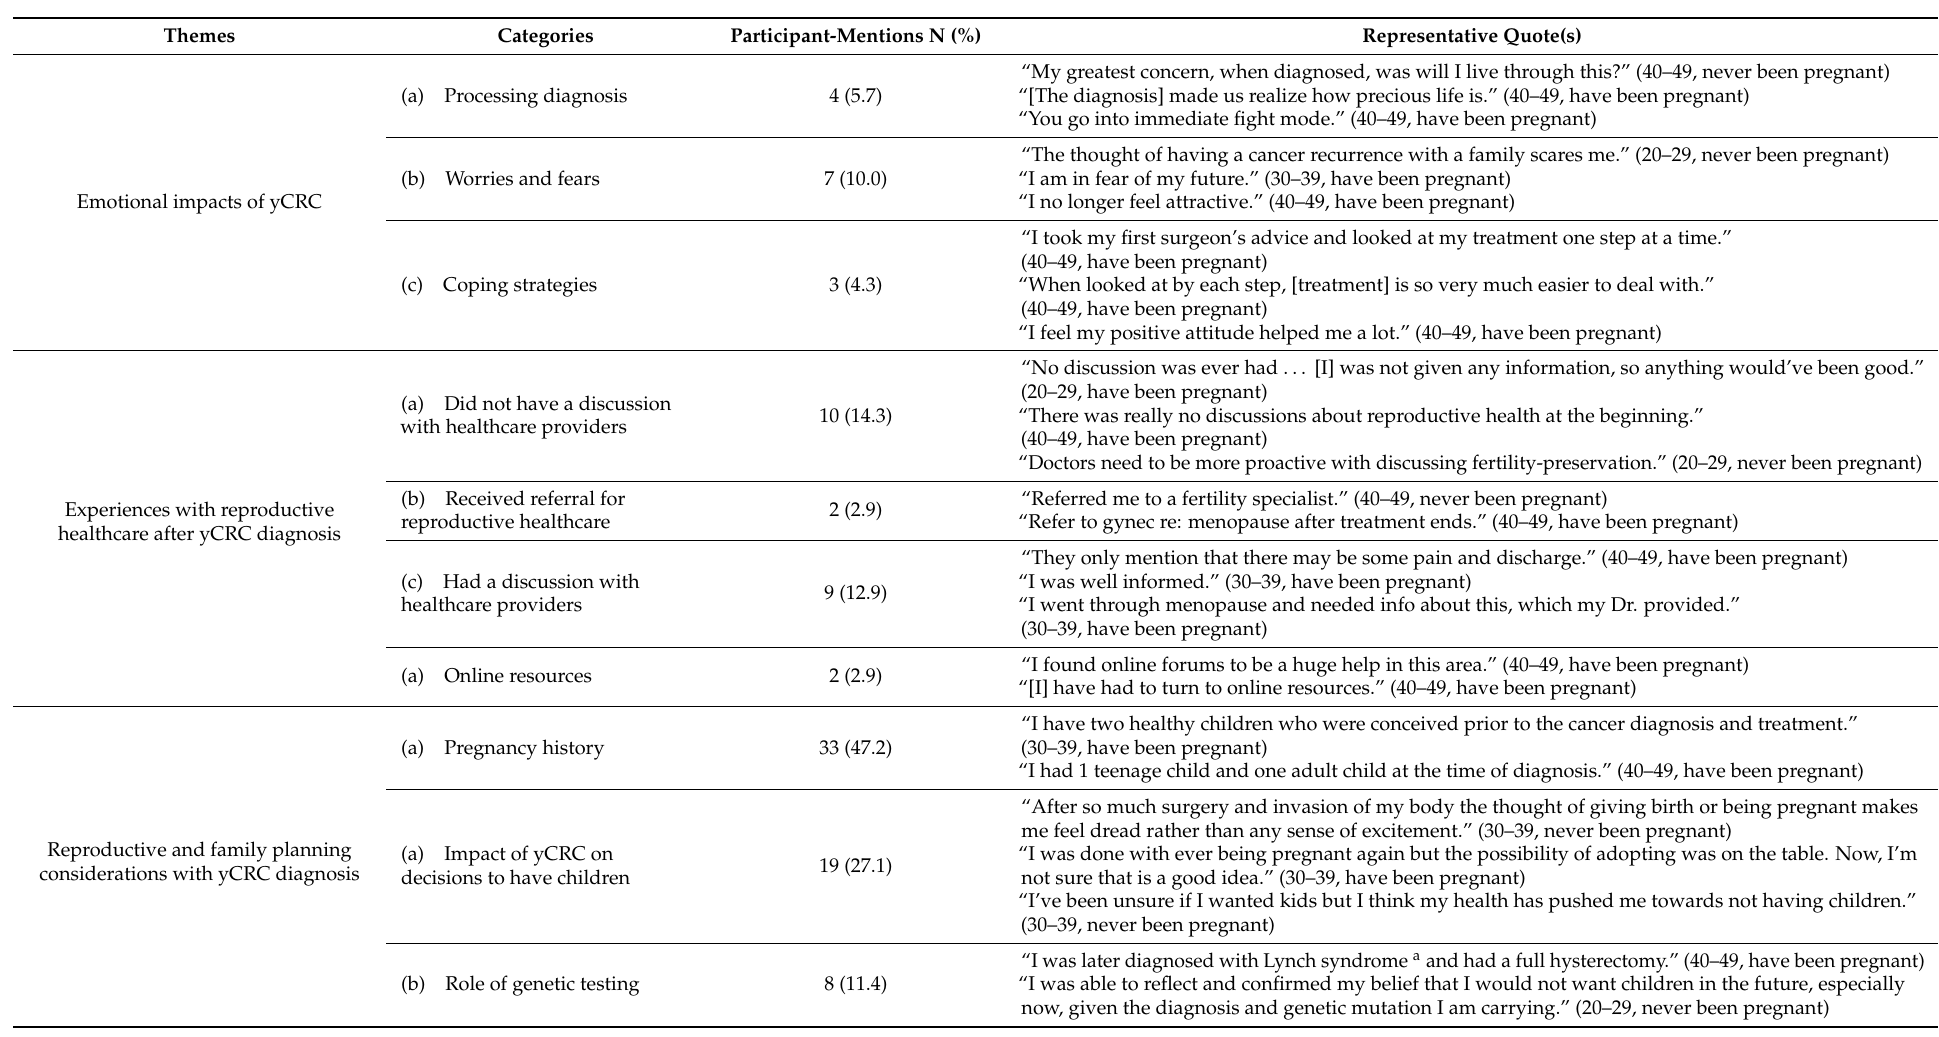
Table 4. Themes and categories arising from content analysis of responses to open-ended survey questions regarding reproductive and sexual health experiences in relation to yCRC diagnosis (N = 70